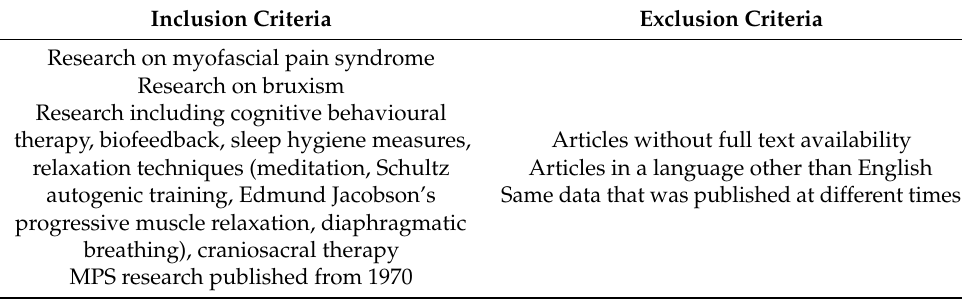
Table 1. The inclusion and exclusion criteria for articles. Inclusion